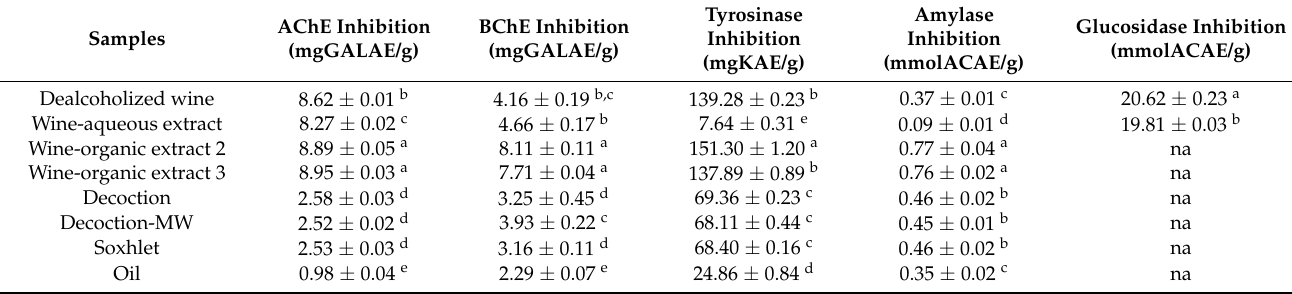
Table 6. Enzyme inhibitory properties of wine